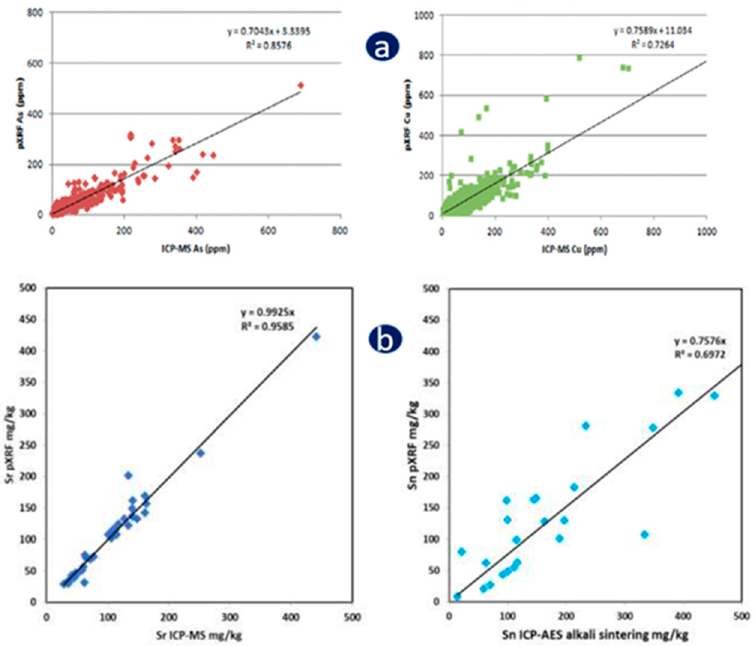
Figure 16. Good correlation between field data (pXRF) and laboratory data (ICP-MS) on the same sample splits for different trace elements, modified from ( a ) [145] and ( b ) [49]. Table 5. Comparison of pXRF (in field) and laboratory XRF results for the four reference till samples [148].